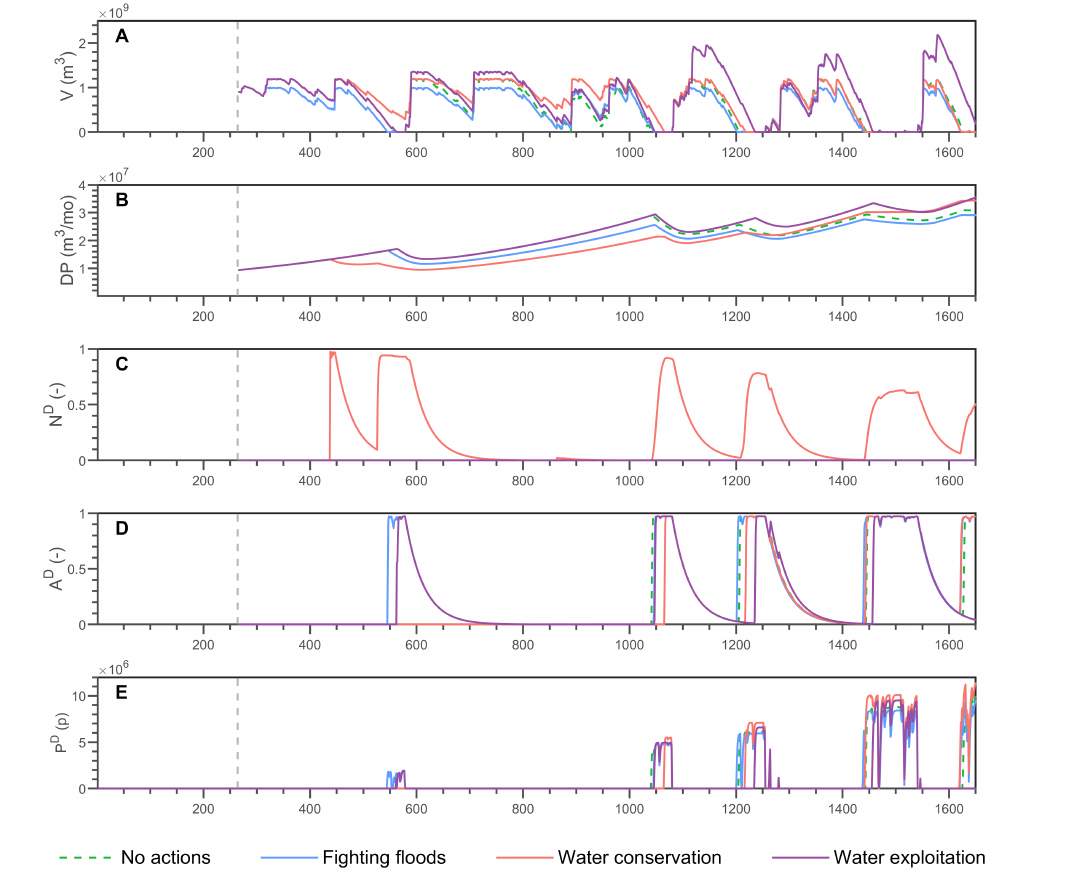
Fig. 7 . Water shortage-based variables of the synthetic numerical experiments considering dam construction and human-flood interactions with the four water-management strategies introduced in this study. (A) reservoir volume (V), (B) total water demand (DP), (C) willingness adopt the new per-capita demand (N D ), (D) drought awareness (A D ), and (E) population affected by droughts (P D ). The gray dashed line indicates the construction of the Wivenhoe